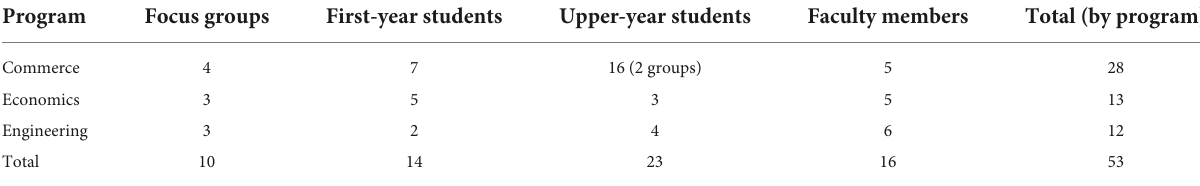
TABLE 1 Number and composition of focus